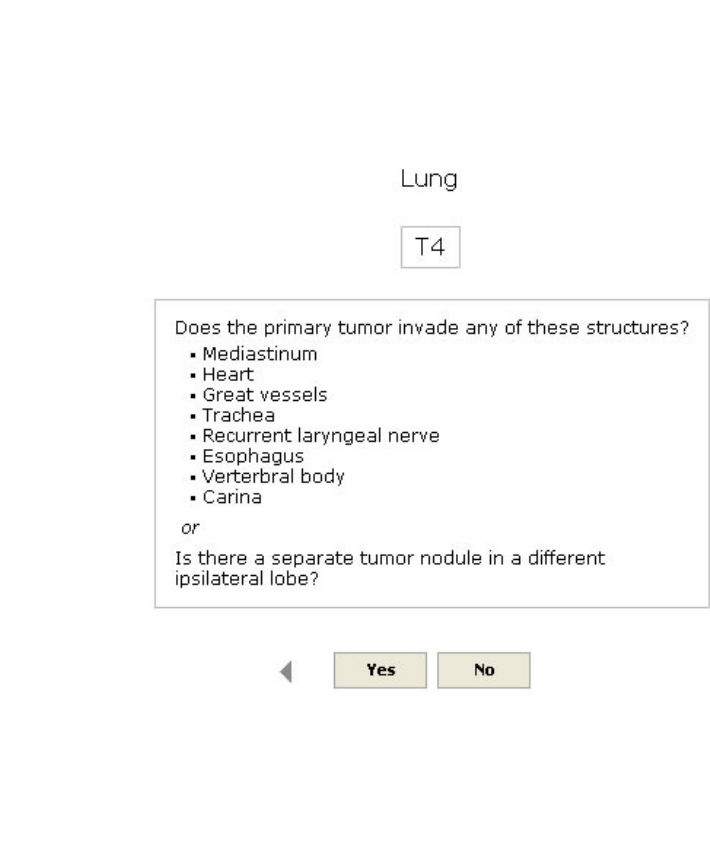
Figure 1. Clicking a response to the prompted question triggers fading of nullified TNM groupings. Forward and back arrows can be clicked to scroll through the sequence of selected and excluded